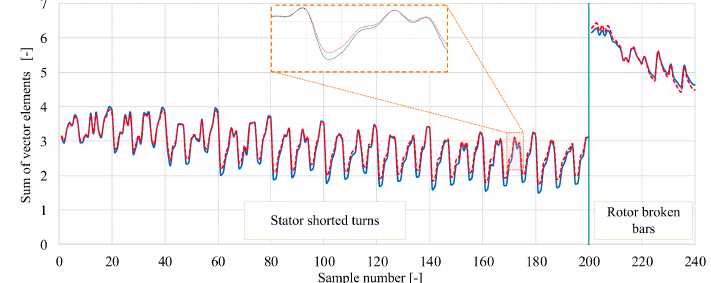
Figure 13. RHN response to a given learning data vector.